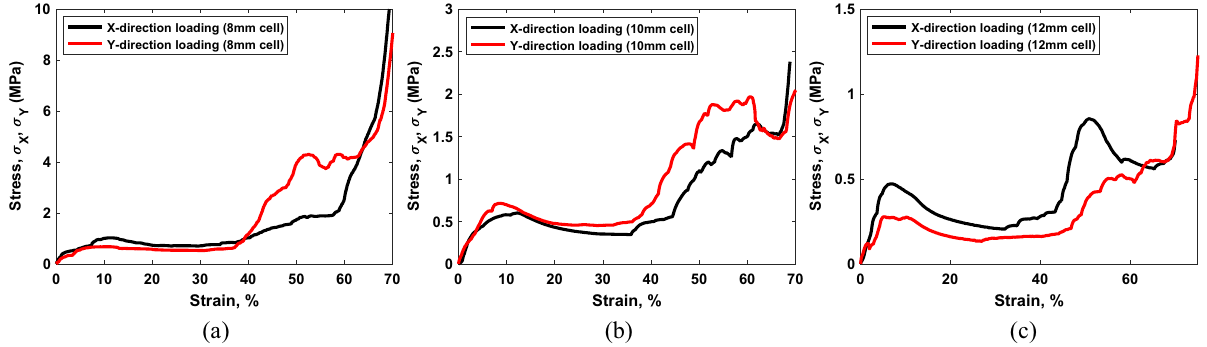
Figure 9. Stress vs lattice strain curves of 2 × 2 × 2 cell lattice structures for X and Y -axis loadings: ( a ) 8 mm cell, ( b ) 10 mm cell, and ( c ) 12 mm